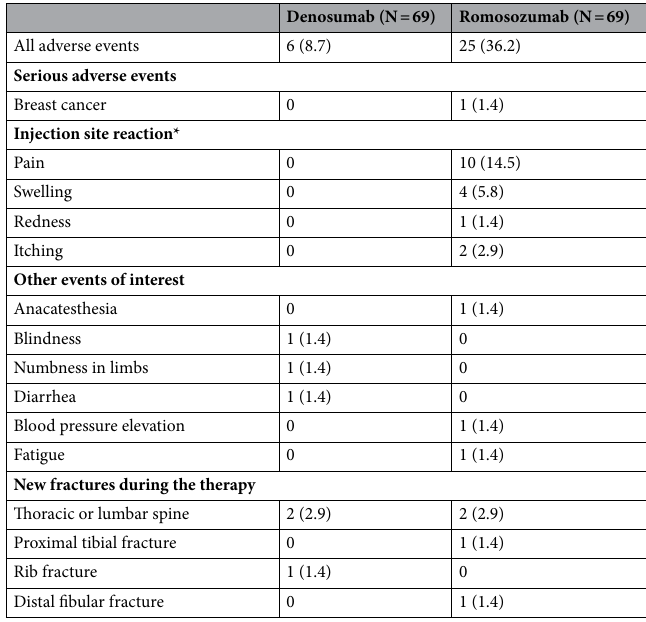
Table 3. Adverse events and new bone fractures during treatment. Data are expressed as the number of subjects (%). *Injection site reactions included adverse events on the skin at the injection site lasting 2 days or